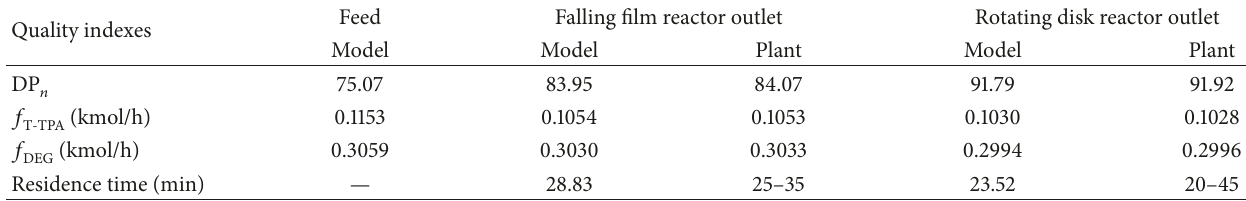
Table 4: Quality indexes values of the falling film-rotating disk combined